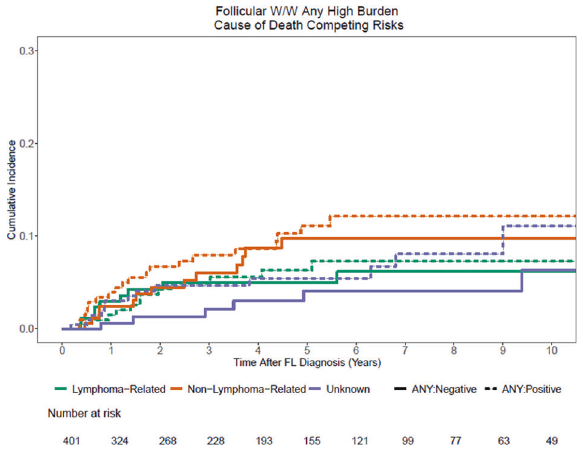
Fig. 3 Cause of death estimates. Cumulative incidence estimates of cause of death based on presence of any treatment initiation